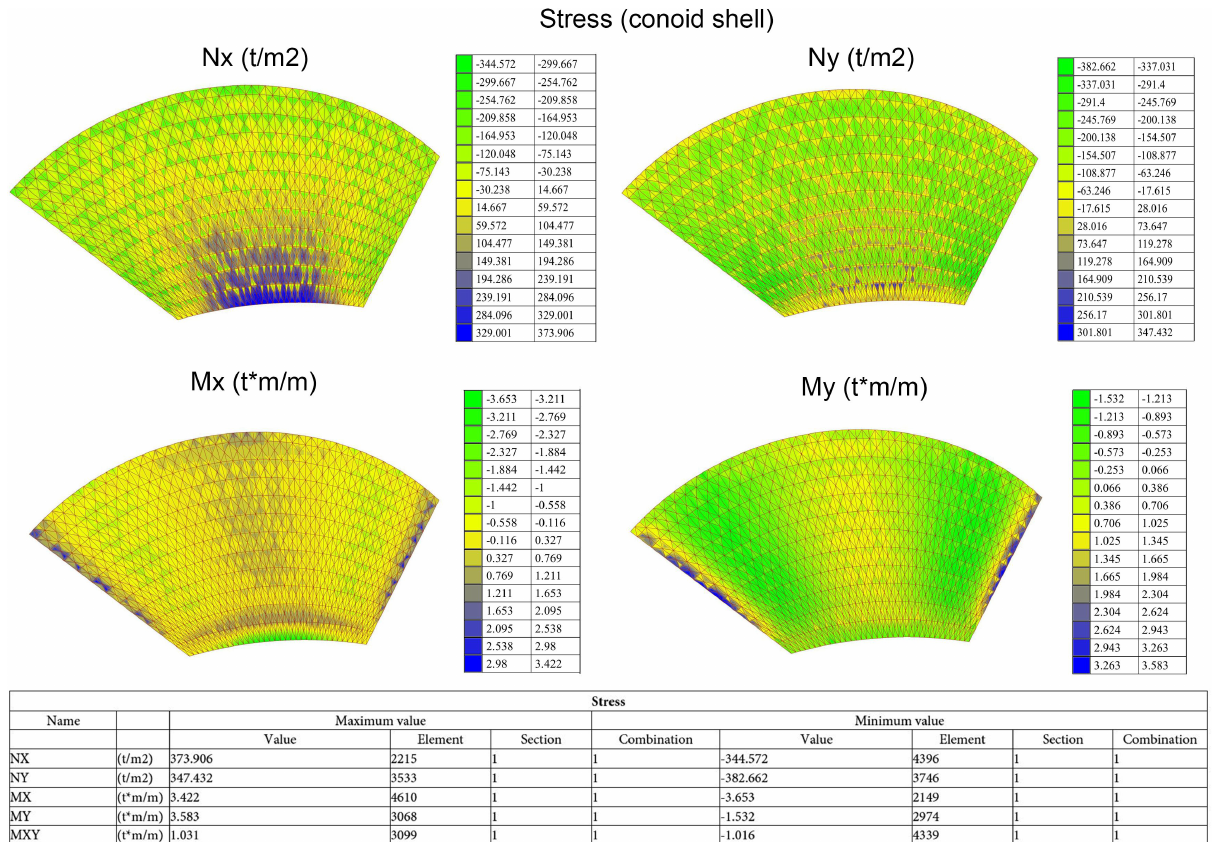
Figure 10: The normal stresses of the conoid